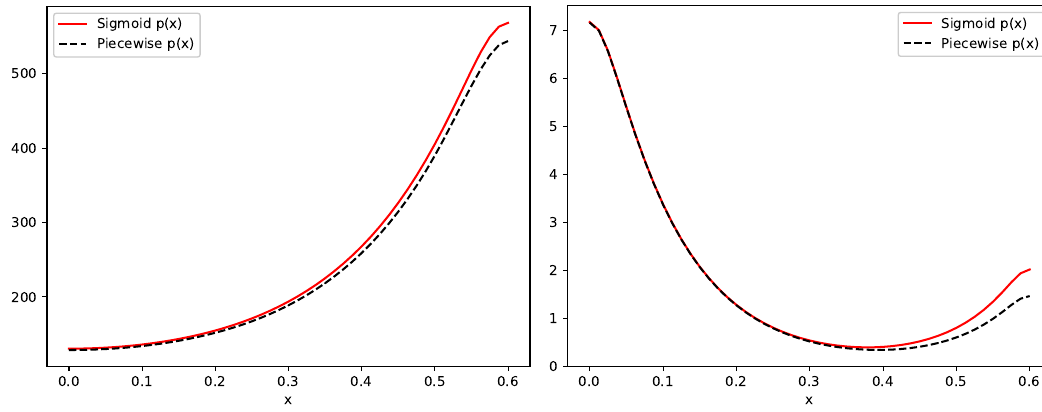
Figure 4. Concentration of growth factors s 1 (left) and s 2 (right) at the final